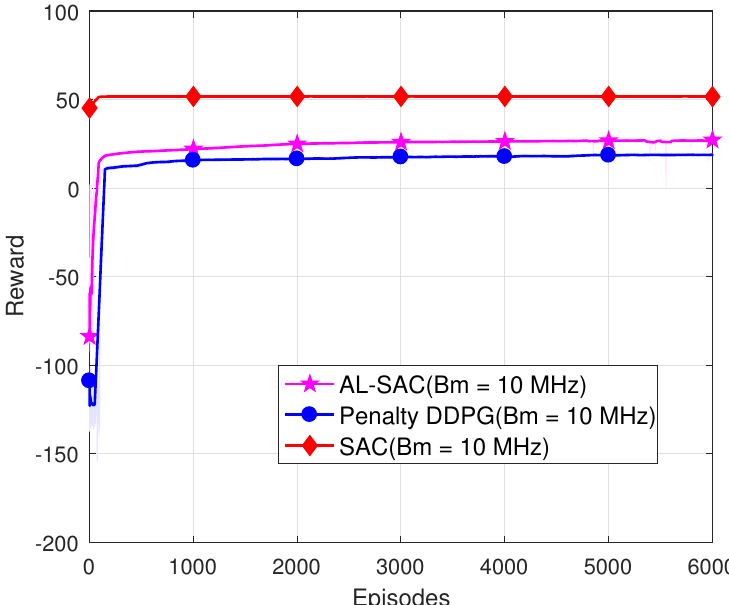
Figure 6. The reward achieved by different algorithms during the training process.